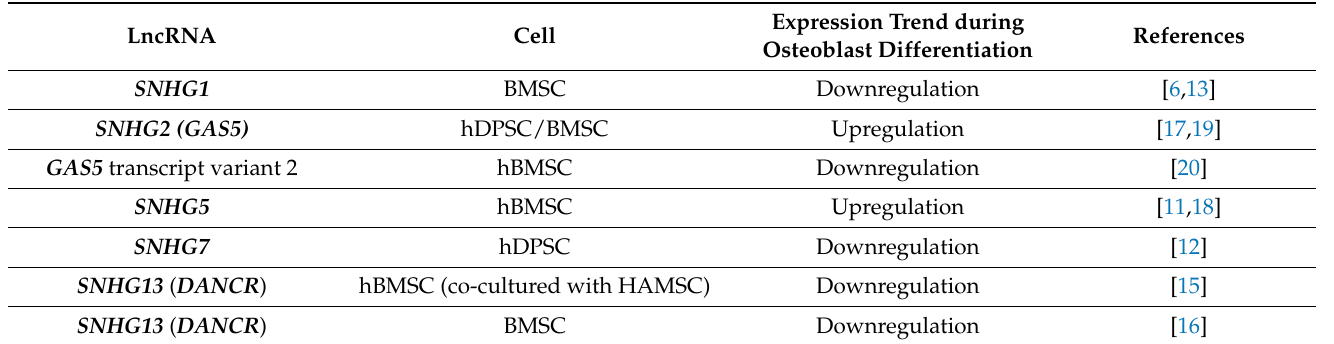
Table 1. SNHG expression trends during osteoblast